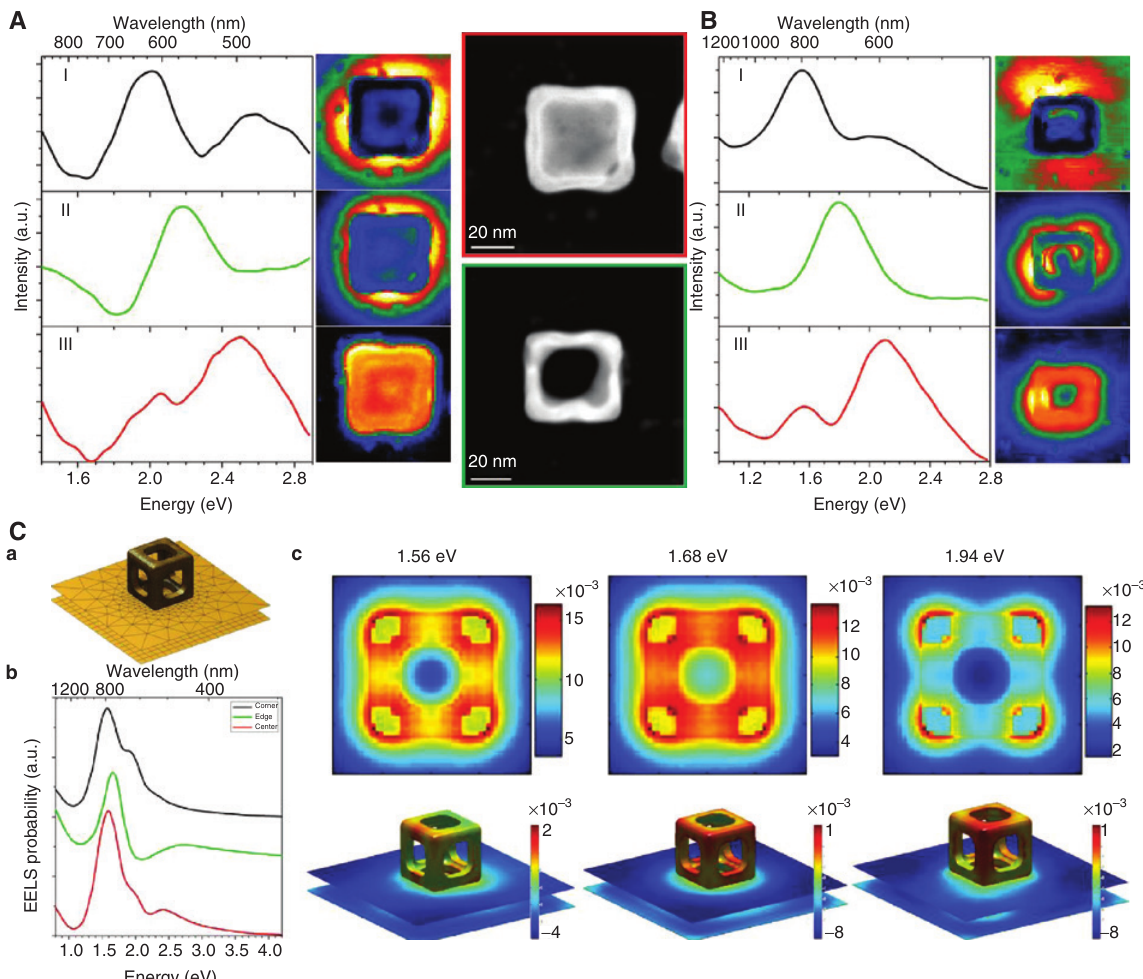
Figure 7: Plasmonic properties of single-walled AuAg nanobox and AuAg nanoframe. (A) Spectra and abundance maps of three plasmon components of the single-walled AuAg nanobox (marked with red), obtained by vertex component analysis (VCA) processing. (B) Spectra and abundance maps of three plasmon components of the AuAg nanoframe (marked with green), obtained by VCA processing. (C) BEM simula- tions of the AuAg nanoframe. (C-a) Structural model used during simulations. (C-b) Simulated local EEL spectra obtained from the corner, edge, and center of the nanoframe. (C-c) Simulated plasmon maps of three different LSPR modes located at 1.56, 1.68, and 1.94 eV along with their corresponding induced electric field intensity distribution with an edge beam excitation in 3D (lower row) (adapted with permis- sion from Ref. [133], copyright 2016 American Chemical